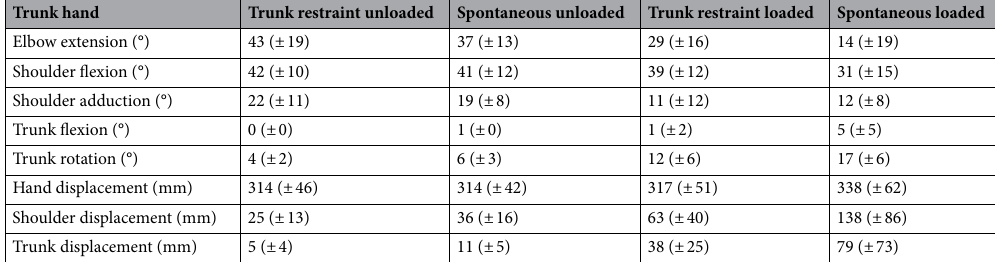
Table 1. Differences in angular rotation and raw displacements between final and initial posture. Trunk displacement is the distance travelled by the manubrium: it captures mainly trunk anterior flexion. Shoulder displacement is the distance travelled by the acromion process: it is sensitive to both trunk anterior flexion and trunk rotation. When the hand is unloaded and the trunk is restrained, the coordination is mainly based on elbow and shoulder use (left of the table). When the hand is loaded or the trunk is free, trunk recruitment increases, which reduces elbow and shoulder use (right of the table).